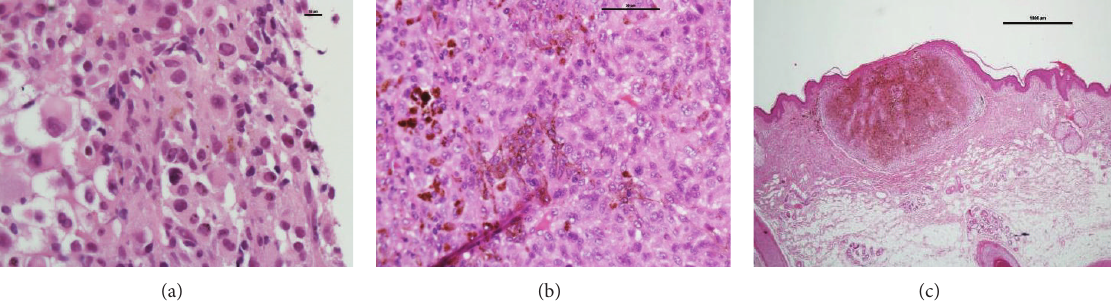
Figure 3: H&E stains on initial biopsy (a), metastasectomy (b), and primary melanoma excised from the neck (c).